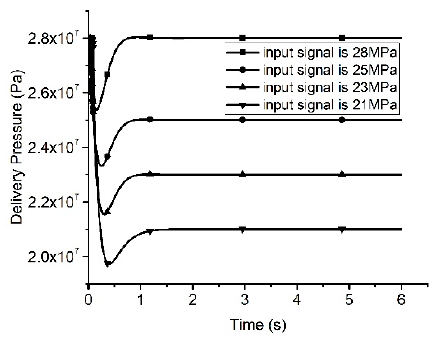
Figure 5. The delivery pressure of EHPAAPP in the case of different input signals with proportional integral derivative (PID) control method.